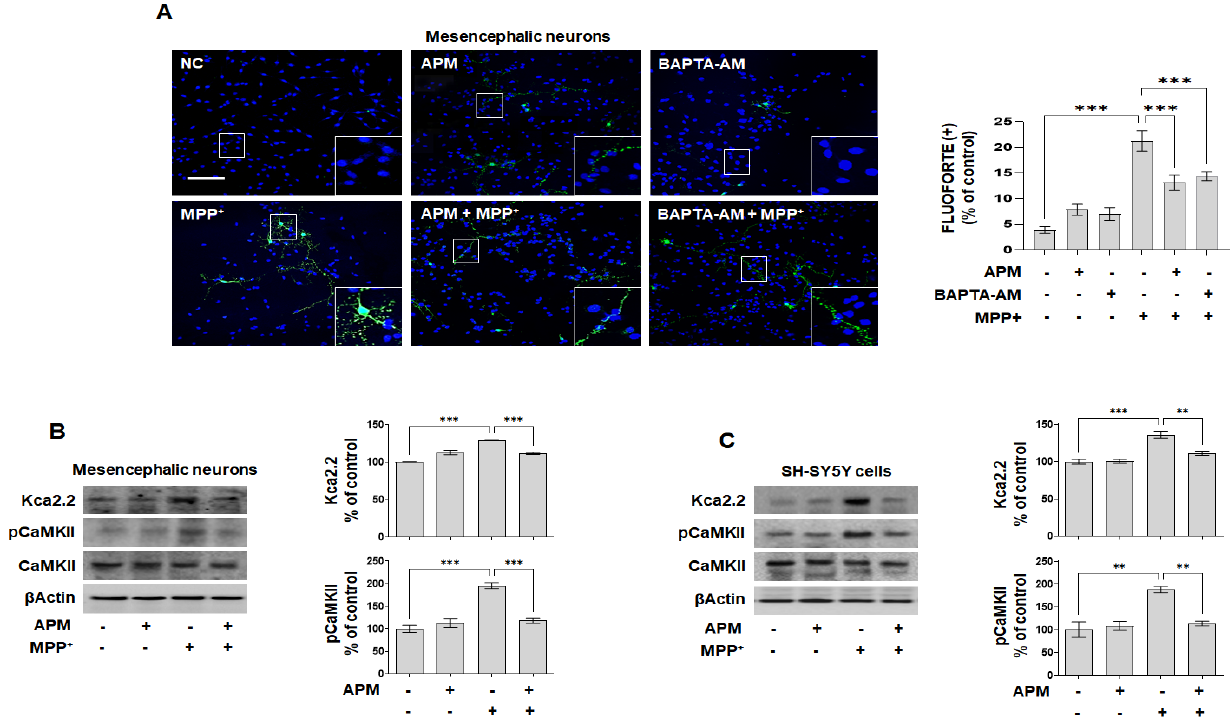
Figure 3. APM inhibited MPP + -induced SK channels in dopaminergic neuronal cells. SH-SY5Y cells and rat embryo primary mesencephalic neurons were incubated in the presence or absence of APM or BAPTA-AM (5 μ M) for 1 h and then treated with MPP + for 24 h. ( A ) Intracellular Ca 2+ overload positive cells of rat embryo primary mesencephalic neurons were evaluated using fluorescence microscopy using FLUOFORTE staining (green, scale bars: 100 µ m). Nuclei were stained with DAPI (blue). APM significantly inhibit MPP + -induced Kca2.2 and pCaMKII expression in rat embryo primary mesencephalic neurons ( B ) and SH-SY5Y cells ( C ). β Actin was used to confirm equal sample loading. Immunoblotting and immunofluorescence positive cells were quantified by densitometric analysis. The data are representative of three independent experiments and quantified as mean values ± SEM. Tukey’s multiple comparison test, ** p < 0.01, *** p < 0.001 compared to normal control.